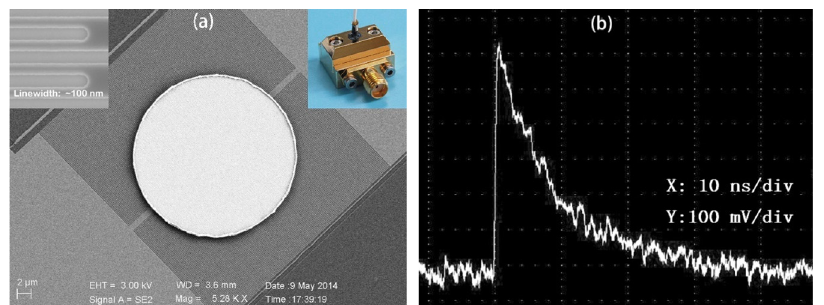
(distributed Bragg re fl ector) with frontside illumination (OS4 Figure 5(a) [38]. In principle, the optimized OS3 and OS4 may achieve an absorption of more than 0.99 ac- cording to simulation. However, based on the simulation